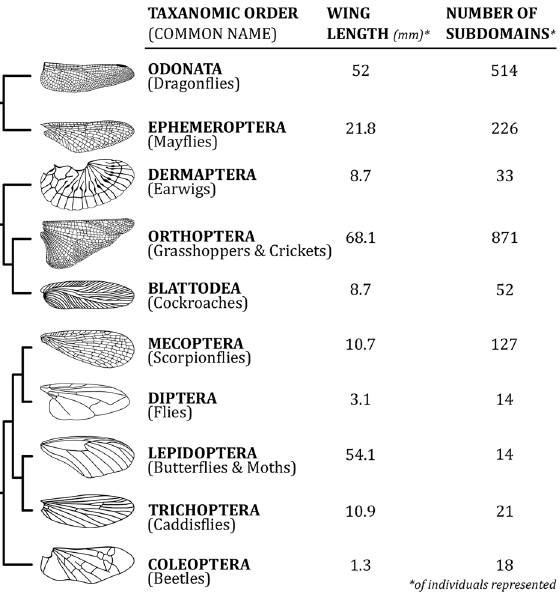
Figure 1. Wings from ten representative insect orders were analysed and modelled using WingGram (wing drawings were taken from 16